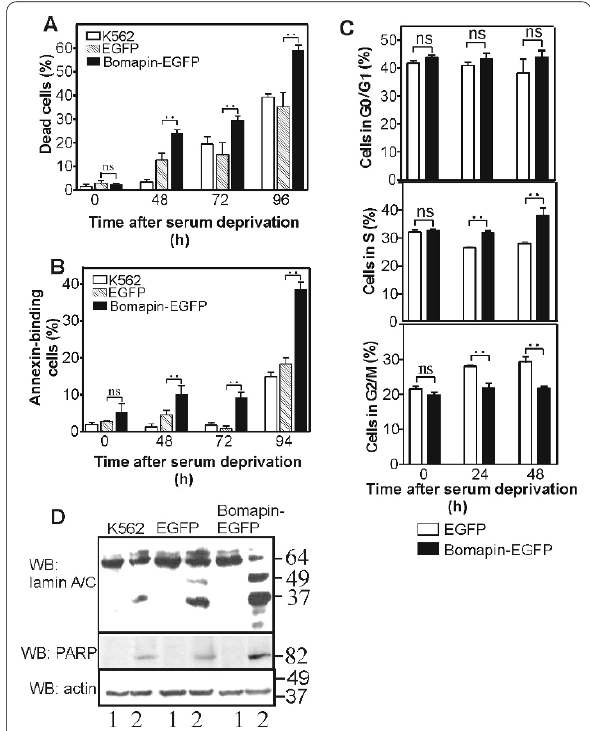
Figure 4 Bomapin enhances cell apoptosis following growth fac- tors withdrawal . K562 cells and the cells expressing bomapin-EGFP or EGFP were incubated in the presence or the absence of serum in the media. At different time points, cells were mixed with trypan blue and dead cells were quantified by manual counting (A), or the cells were in- cubated with annexin-PE-Cys5, and annexin-labelled cells were quan- tified under fluorescence microscope with excitation and emission wavelengths 488 nm and 670 nm, respectively (B); (C) Progression of cell cycle in bomapin-EGFP and EGFP-expressing K562 cells following serum withdrawal. Percentage of G0/G1, S, and G2/M phases were cal- culated by deconvolution of DNA content histograms; ns - insignifi- cant; ".." indicates statistical significance with p < 0.05. (D) K562 cells expressing bomapin-EGFP or EGFP were incubated in serum-contain- ing media (lanes 1) or in media without serum (lanes 2) for 48 h. Then, cell extracts were analyzed by western blot with monoclonal antibod- ies against lamins-A/C and rabbit antibodies against cleaved PARP as apoptotic markers. Western blot for β-actin in the same gel is shown as loading